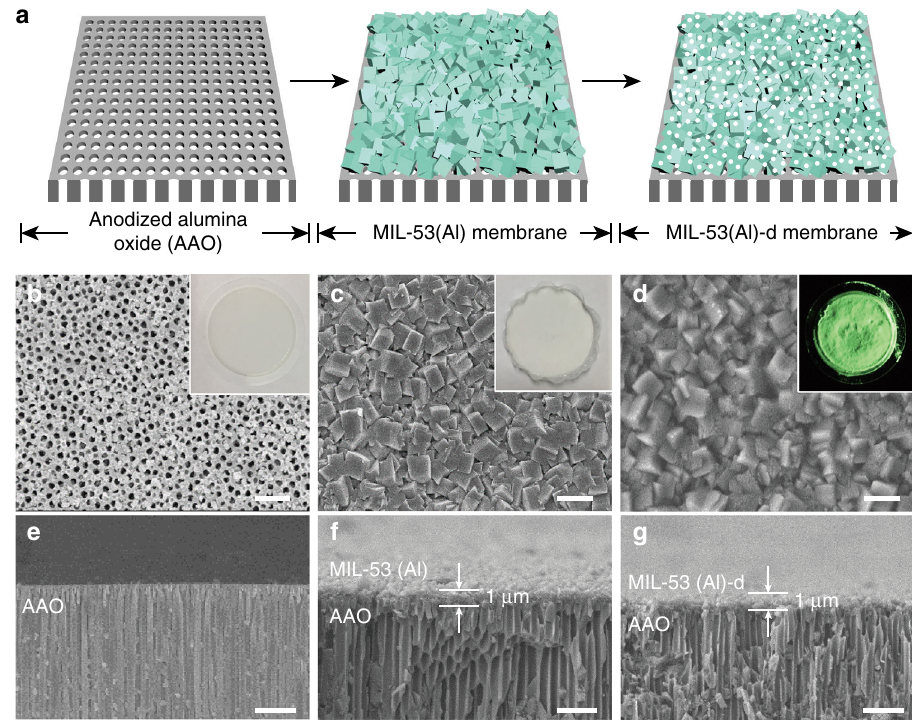
Fig. 5 Mesoporous MOF membranes. a Conceptual illustration of sequential fabrication of MIL-53(Al)-d40 membrane. Top view: SEM micrographs of b AAO membrane, c MIL-53(Al) membrane, and d MIL-53(Al)-d40 membrane. Cross view SEM micrographs of e AAO membrane, f MIL-53(Al) membrane, and g MIL-53(Al)-d40 membrane. b , e AAO membrane as received, c , f growth of MIL-53(Al) membrane for 4 h, and d , g decarboxylated MIL- 53(Al)-d40 membrane. The insets: b digital photo, c , d luminescence images with FITC-dextran. b – d Scale bar is 1 µ m; e – g scale bar is 2 µ